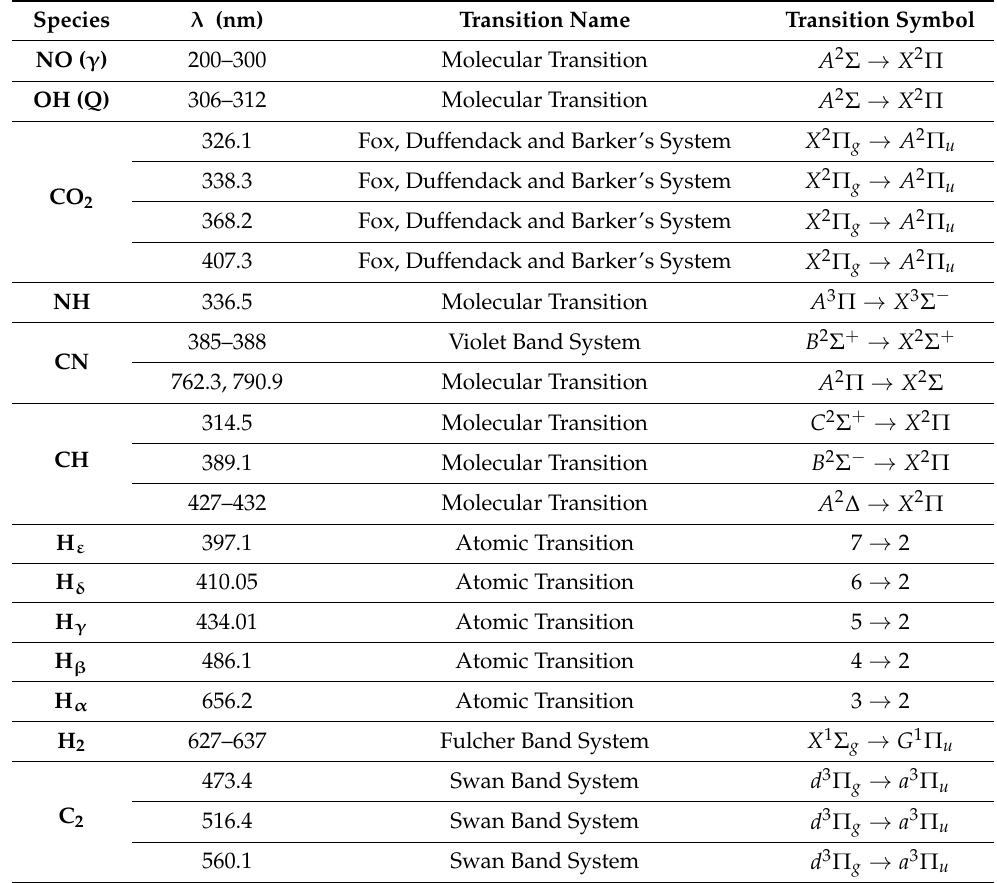
Figure 7. Example of the emission spectrum detected for the rotating electrode AC plasma reactor with the main identified lines at applied voltage of 14 kV, rotation frequency of 18,000 rpm, and gas flow rate of 1 sLm. Table 2. Parameters of the atomic lines and molecular bands detected by OES in the rotating electrode AC plasma reactor [16,17].